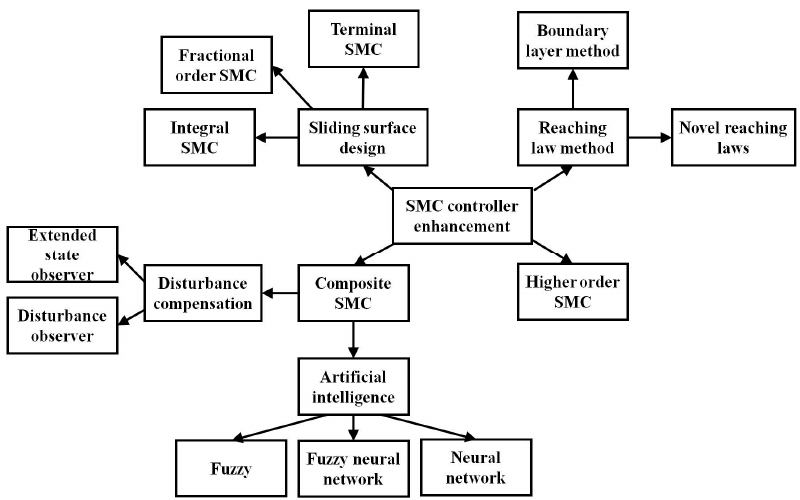
Figure 12. Summary of SMC enhancement methods.